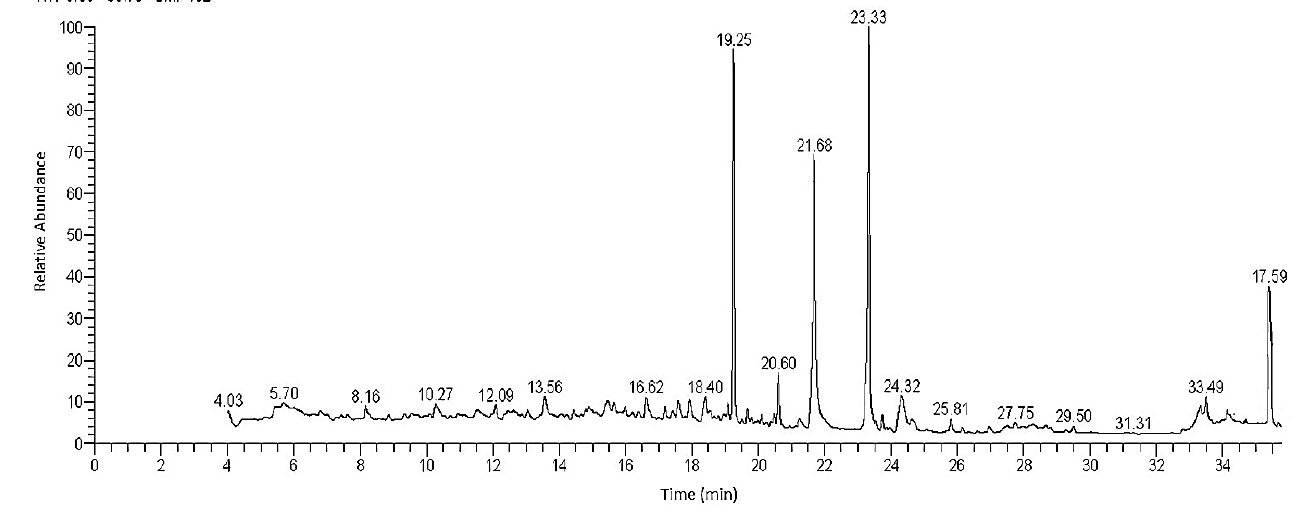
Figure 1. Chromatogram and structures of main components of the methanol extract of R. tingitana shoot by GC-MS.